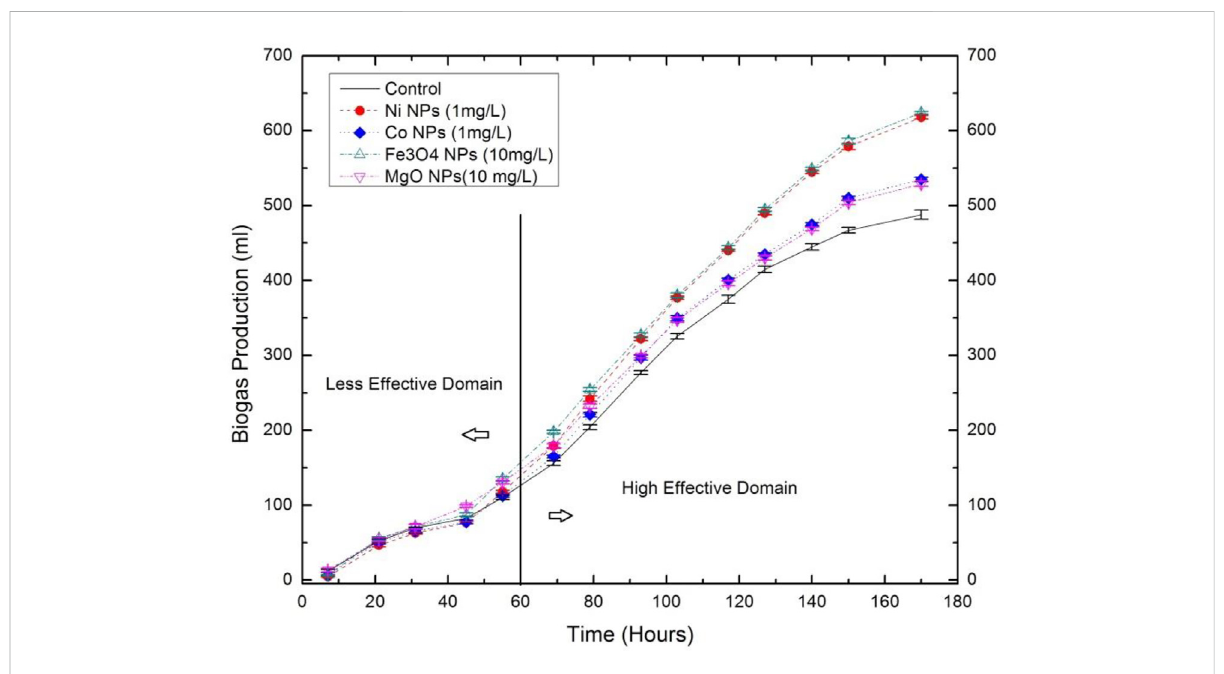
FIGURE 8 Biogas production in fl uenced by nanoparticles (Zaidi et al.,